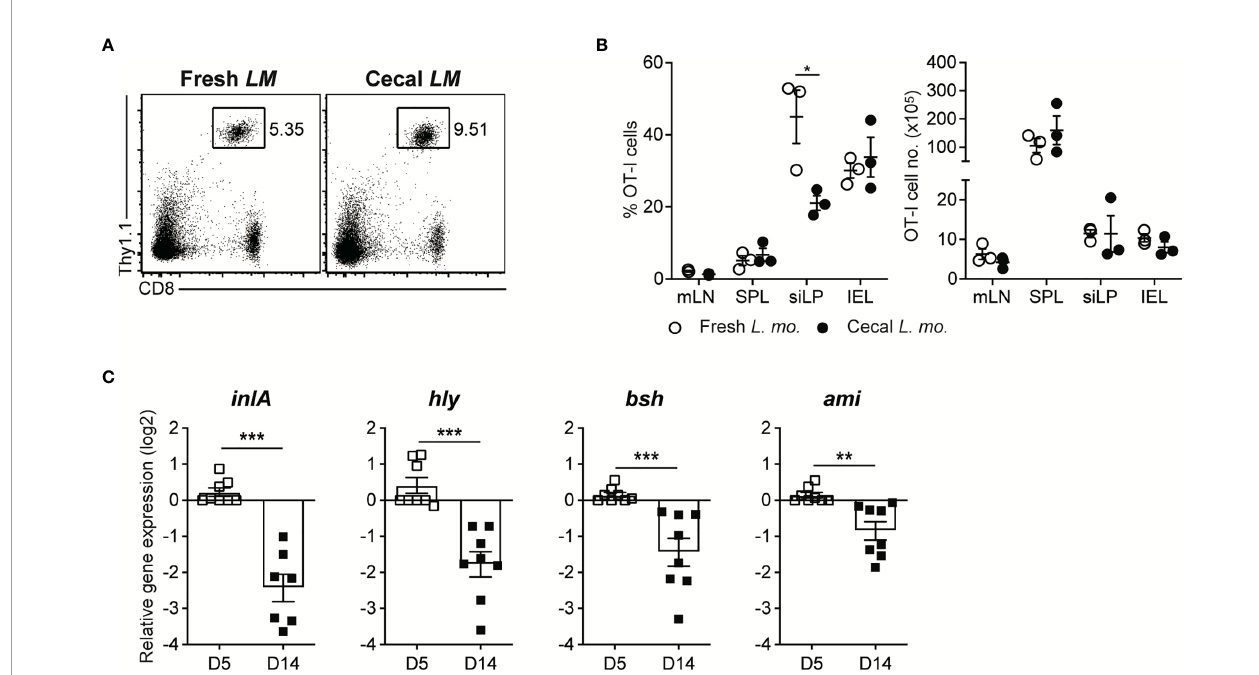
FIGURE 5 | Luminal L. monocytogenes in GF mice Establish Commensalism Through the Downregulation of Virulence Gene Expression. (A, B) 5 x 10 5 OT-I cells were adoptively transferred into GF mice. Next day, mice were orally infected with either InlA m LM-OVA freshly prepared in vitro (Fresh LM) or InlA m LM-OVA isolated from cecum of GF mice previously infected with InlA m LM-OVA (Cecal LM). (A) Representative FACS plots showing the percentage of OT-I cells gated on lymphocytes in SPL at 7 dpi. (B) Percentage of OT-I cells gated on lymphocytes (left) and total numbers (right) of OT-I cells in indicated tissues from InlA m LM-OVA infected GF mice at 7 dpi. Data are representative of two independent experiments (n=3 per group). Statistical differences were determined two-way ANOVA with Tukey ’ s multiple comparisons. *P < 0.05. (C) qRT-PCR analysis for the expression of the virulence genes ( inlA , hly , bsh , and ami ) in InlA m LM-OVA isolated from InlA m LM-OVA infected GF mice at 5 and 14 dpi. Gene expression was normalized to bacterial 16s RNA. Results are pooled from at least two independent experiments (n=8 per group). Statistical differences were determined by unpaired two-tailed Student ’ s t test. **P < 0.01, ***P <